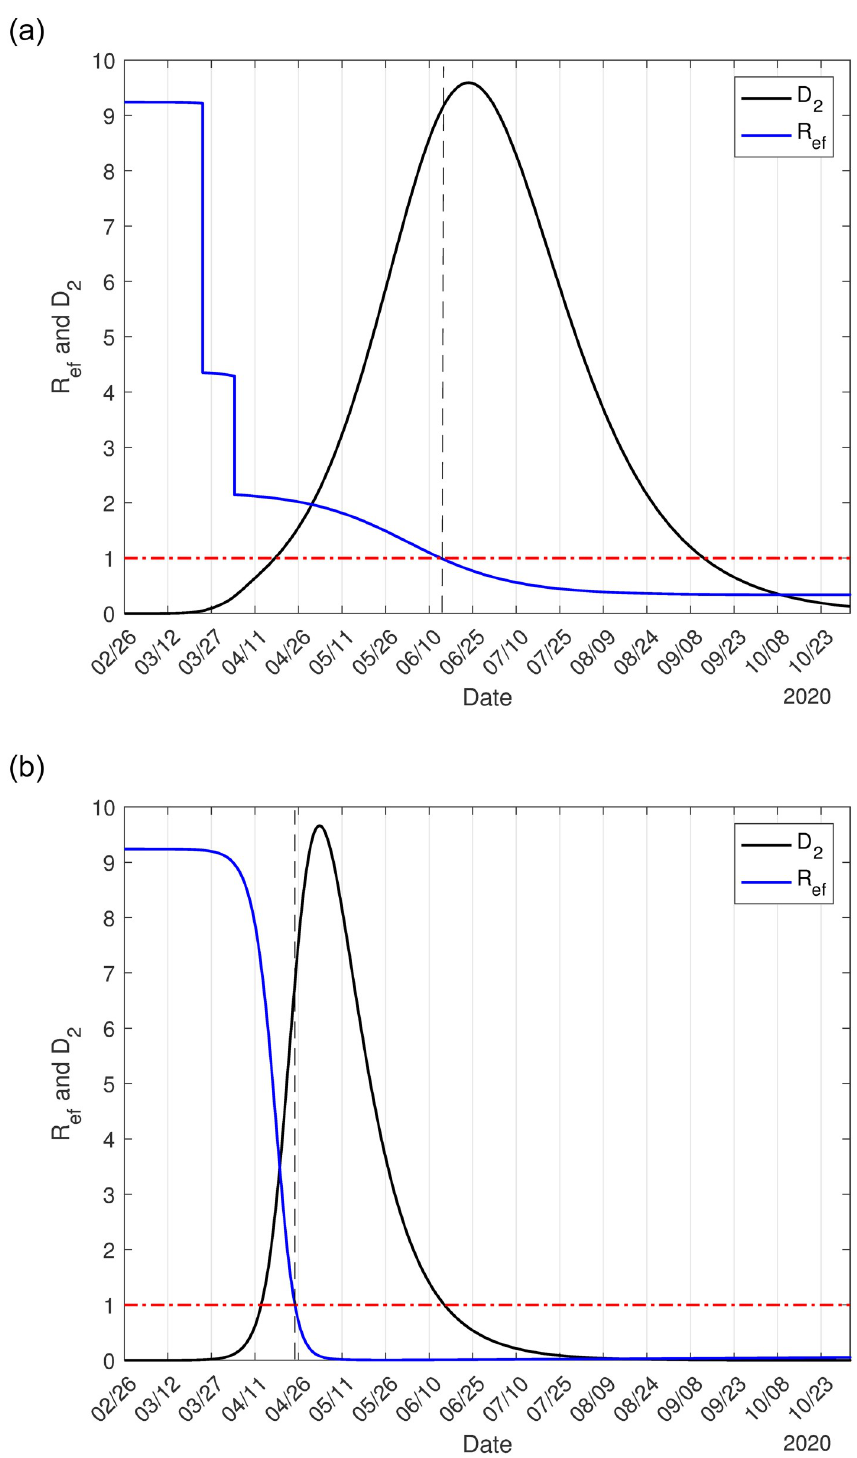
Fig 3. The effective reproduction number R ef for epidemic with isolation and protective measures (a), and natural epidemic (b) in S ã o Paulo State. The number of severe covid-19 cases D 2 must be multiplied by 7, 000 (a) and 40, 000